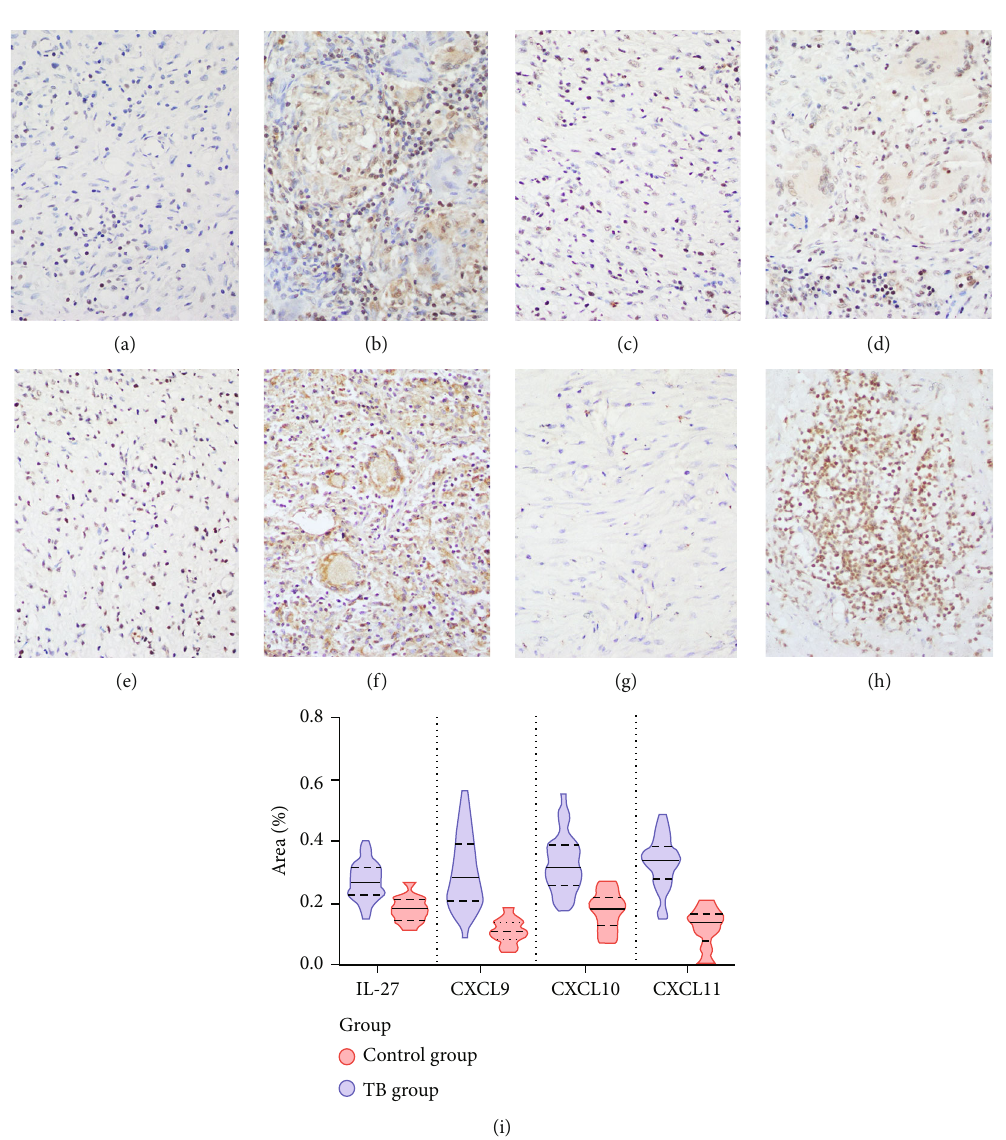
Figure 2: Pulmonary tuberculosis immunohistochemical results. (a, b) Distal side control and TB group interleukin-27 immunohistochemistry staining ( × 200). (c, d) Distal side control group and TB group CXCL9 immunohistochemistry staining ( × 200). (e, f) Distal side control group and TB group CXCL10 immunohistochemistry staining ( × 200). (g, h) Distal side control group and TB group CXCL11 immunohistochemistry staining ( × 200). (i) Interleukin-27 and CXCL9/10/11 immunohistochemistry staining statistical